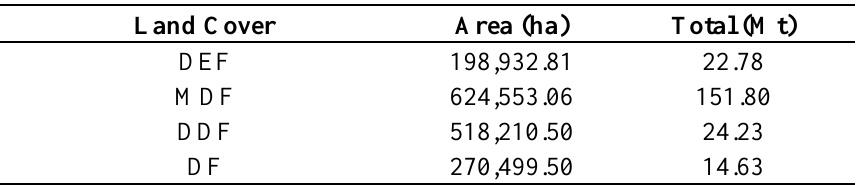
Table 12. The total carbon stock in Savannakhet Province, Lao People’s Democratic Republic